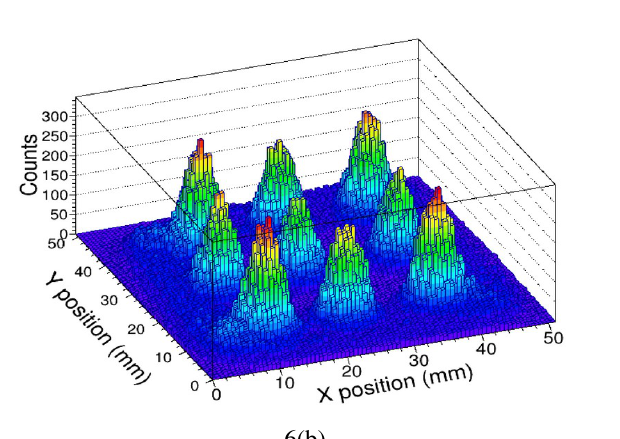
Fig. 6: a) GEANT4 simulated and b) experimental result of nine irradiation spots with 2 mm collimated 122 keV gamma-rays on the LaBr 3 (Ce)-PSPMT crystal.